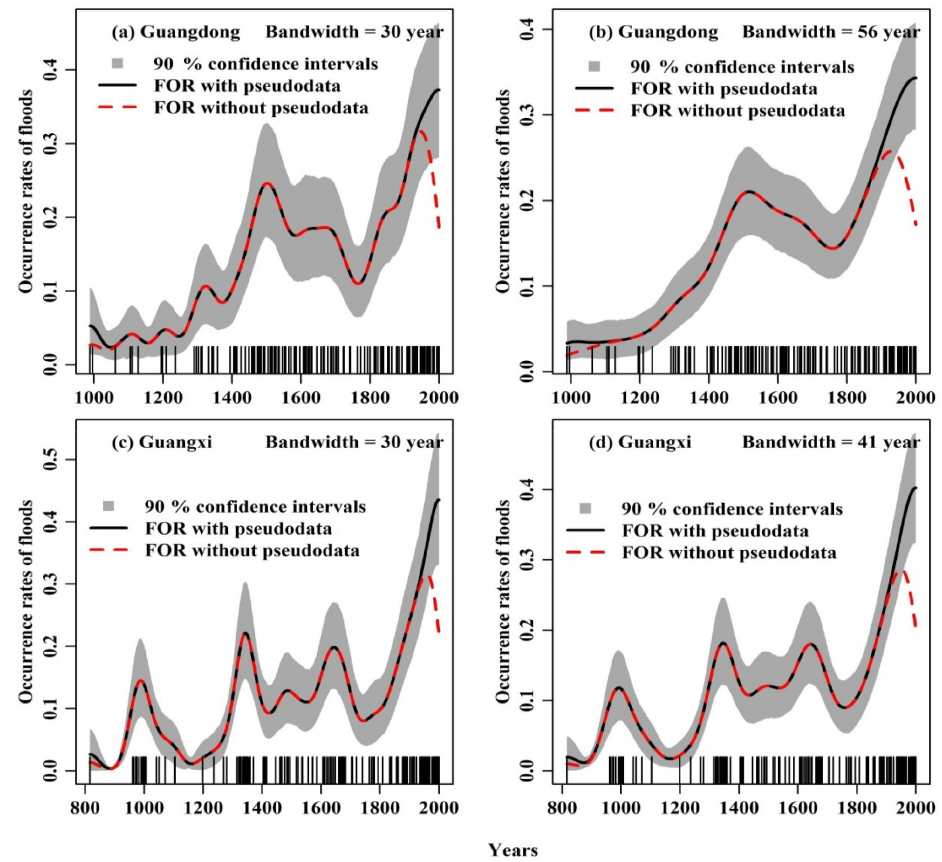
Figure 10. Temporal variations of frequency of flood hazards during the past 1000 years in Guangdong and Guangxi